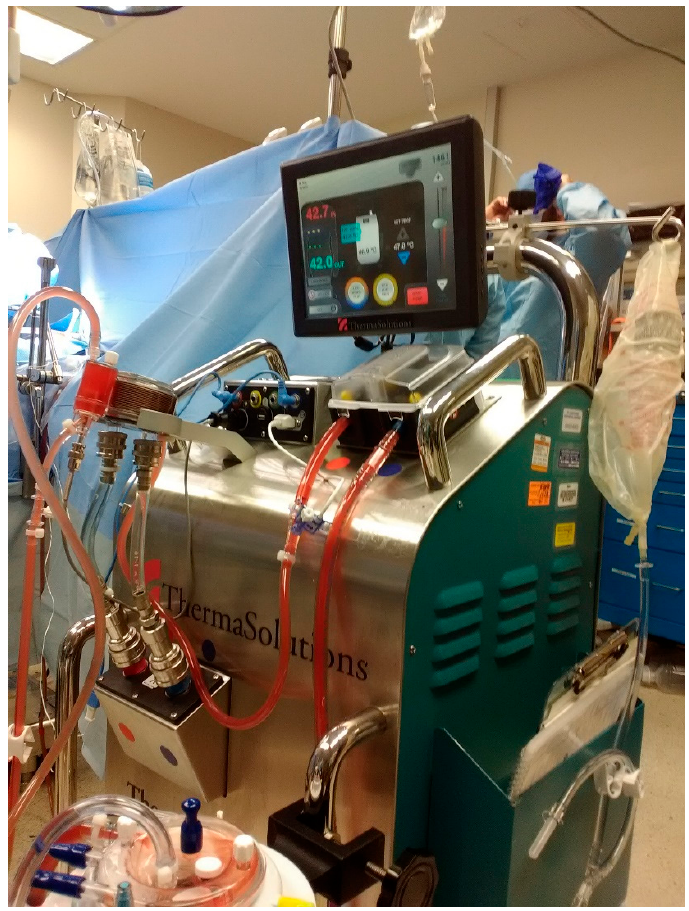
Figure 3. Genesis Medical System for hyperthermic chemotherapy.